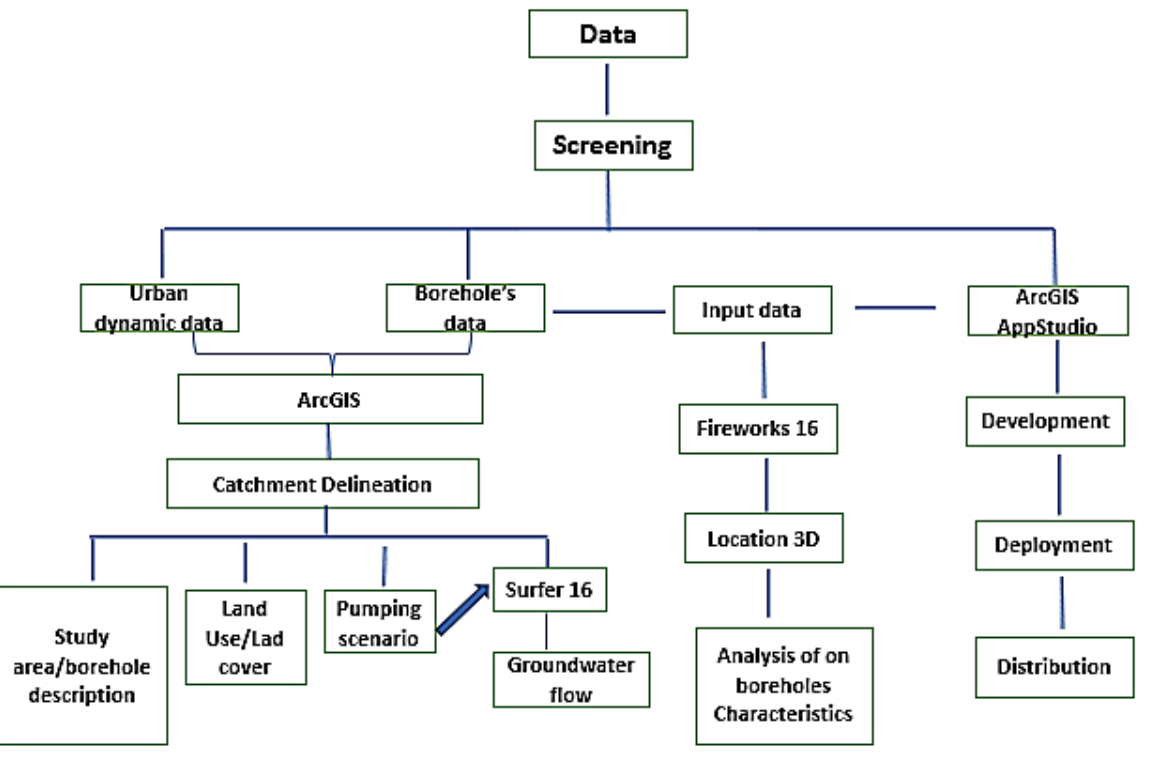
Figure 5. Methodology framework.